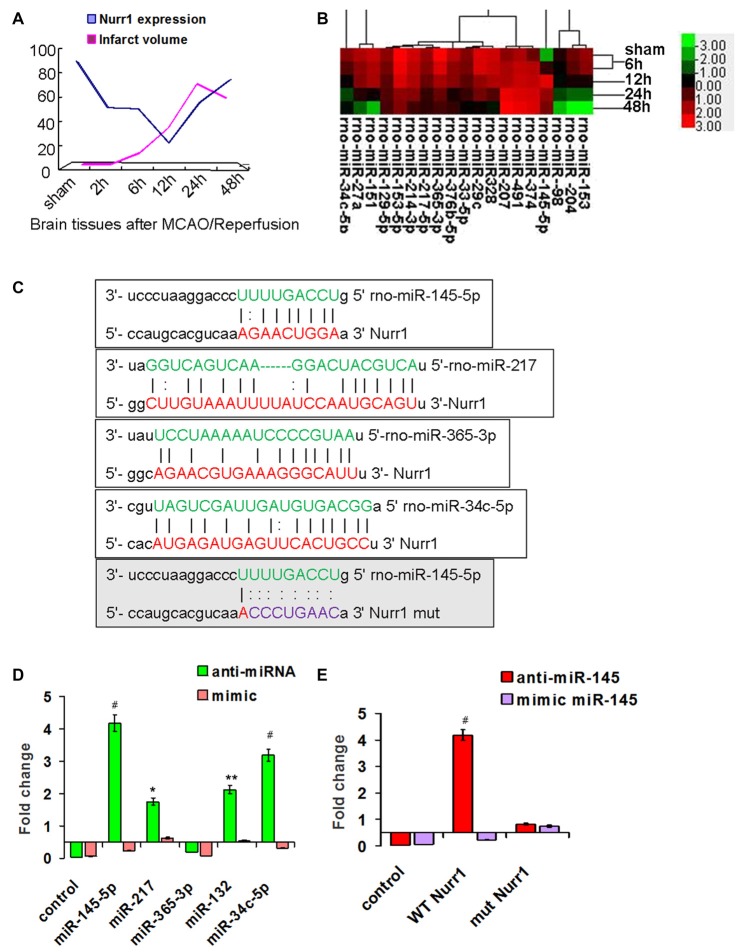
Screening for miRNAs that directly target the 3′UTR of Nurr1. (A) The infarct volume was negatively correlated with Nurr1 expression some extent by Pearson correlation test, but was not statistically significant (correlation coefficient −0.457, P = 0.362). (B) Heat map of predicted miRNAs expression in cerebral cortex tissue from sham and MCAO/R animals (one-way analysis of variance (ANOVA), p < 0.05). (C) The predicted binding sites of selected miRNAs (in green color) to the 3′UTR of Nurr1 (in red color) is mapped in this figure. Nucleotides which were altered for mutational studies are marked in gray color of background. (D) Quantitation of the effects of anti miRNAs and miRNA mimics interaction with the 3′UTR of Nurr1. (E) Quantitation of the effects of anti-miR-145-5p and miR-145-5p mimic interactions with the normal binding sites (WT) and mutated binding sites (mut) in 3′UTR of Nurr1. *p < 0.05, **p < 0.01, #p < 0.001.